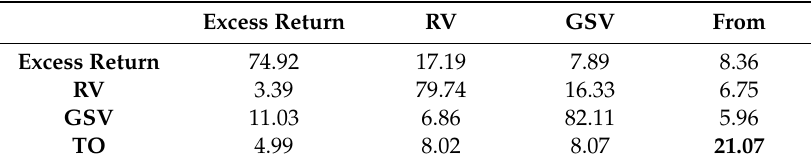
Table 11. Total spillover, Slovenia.